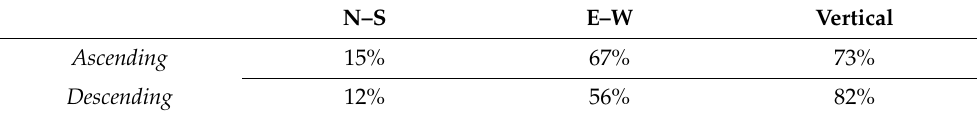
Table 1. The percentage of possible displacement of N-S, E-W and vertical direction that can be detected by the PSInSAR analysis based on the ascending and descending Sentinel-1 SAR images. N–S E–W Vertical Ascending 15% 67% 73% Descending 12% 56%